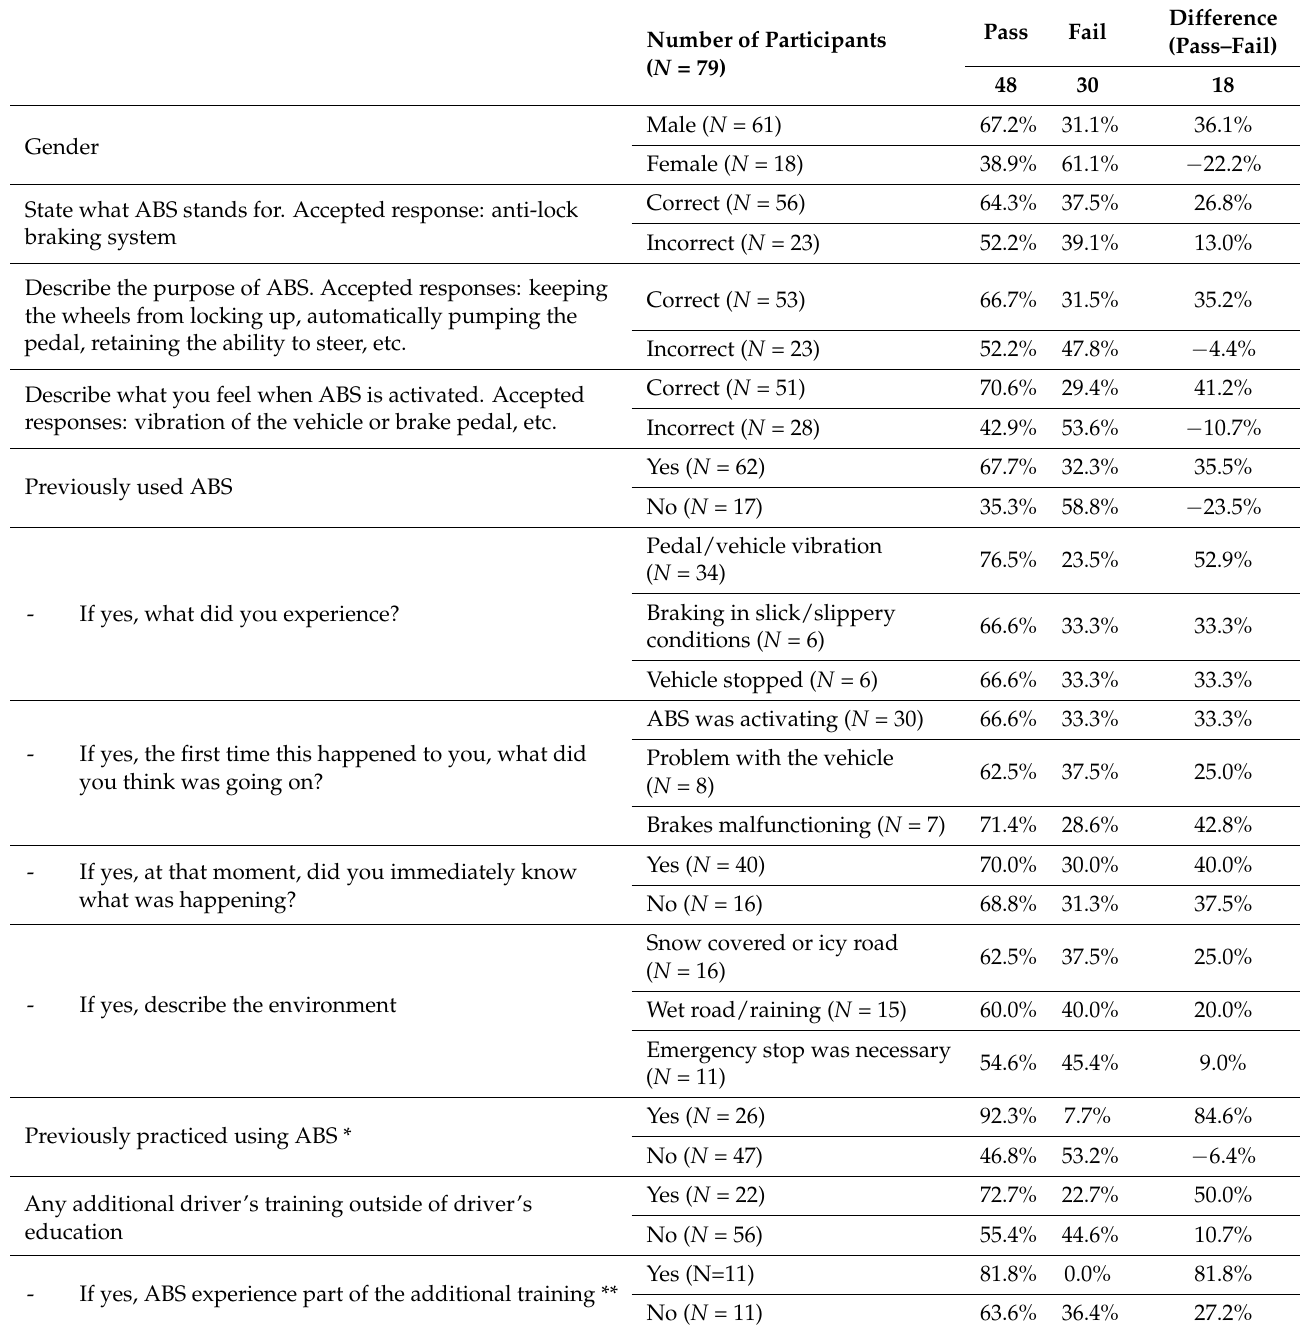
Table 4. Characteristics of participants that passed (instructor rating of 5) or failed (instructor rating of 1 through 4) during the first run of the ABS